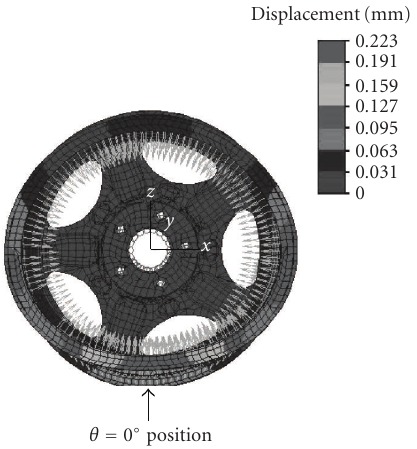
Figure 6: The displacement magnitude of the rim at an inflation pressure of 0kPa (view from inboard